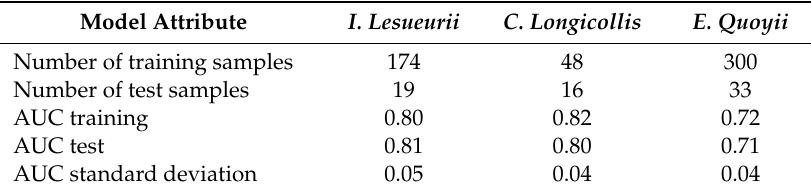
Table 2. Some attributes of the ecological niche models for the three species. AUC is the Area Under the Receiver Operating Characteristics Curve. AUC ranges from 0 to 1, where a score of 1 indicates perfect discrimination and a score of 0.5 implies a predictive discrimination that is no better than random [15].